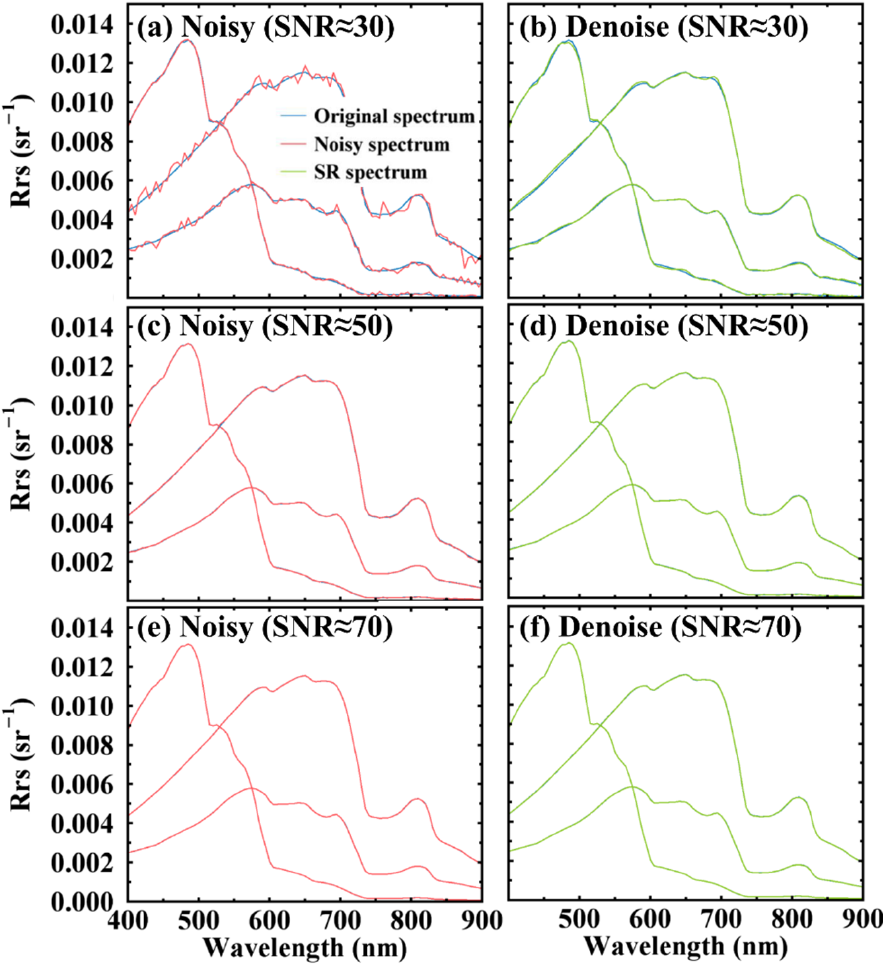
Figure 5. Example spectra of three samples under different SNR levels.